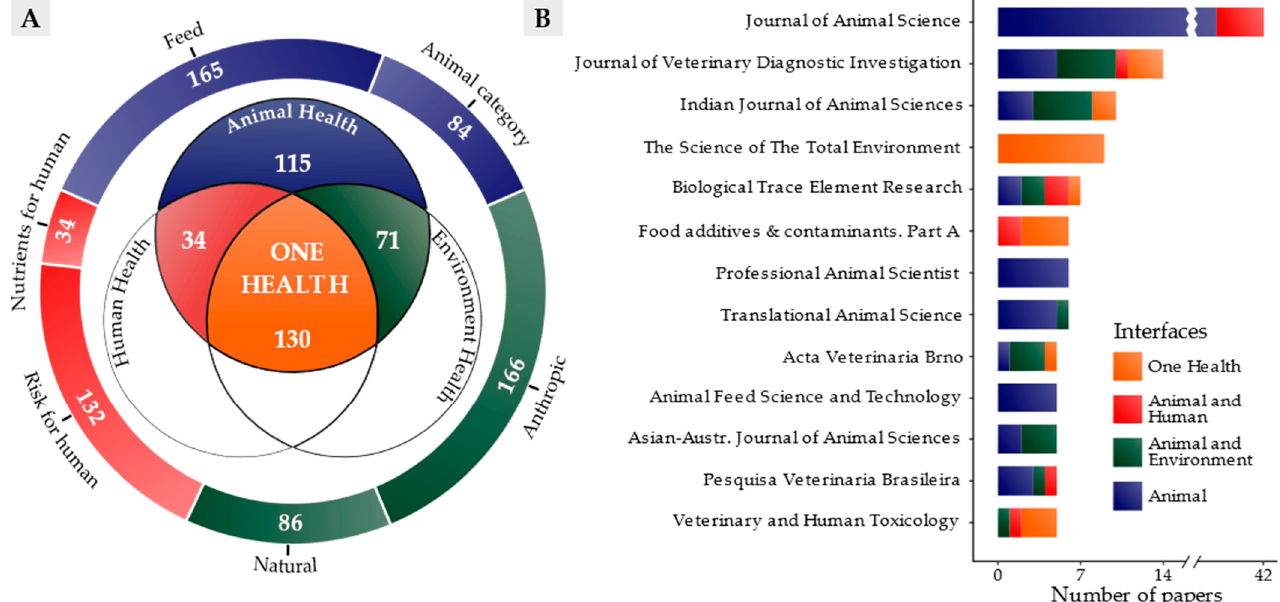
Figure 4. Number of papers published in the period 2000–2022 about trace elements in beef cattle production classified by research scope within the One Health approach: ( A ) interface of number of papers categorized by research aspects and research scope; ( B ) number of papers categorized by main journals and by research scope.